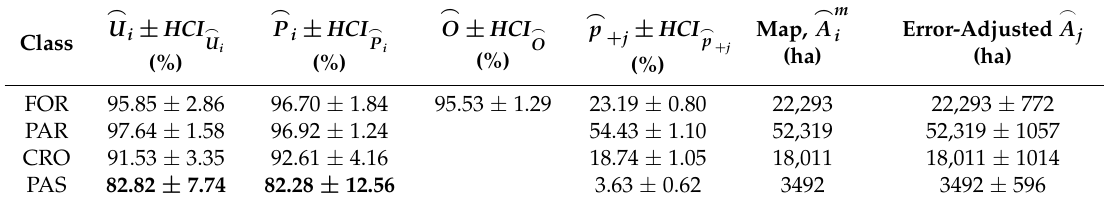
Table 9. Map accuracy and incertitude assessment of the error-adjusted